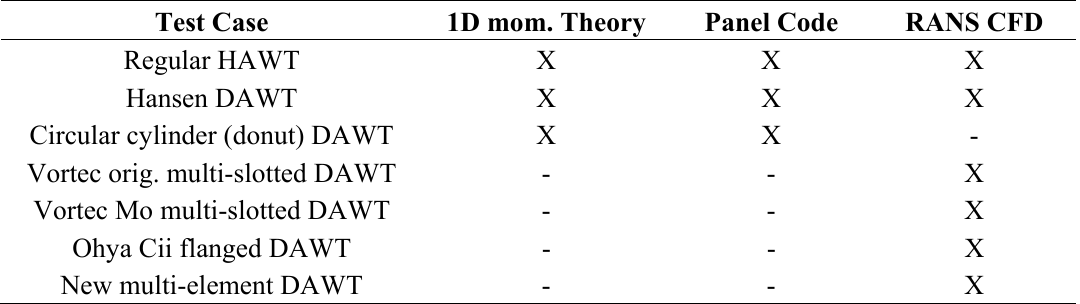
Table 1. Overview of performance evaluation methods applied to each of the test